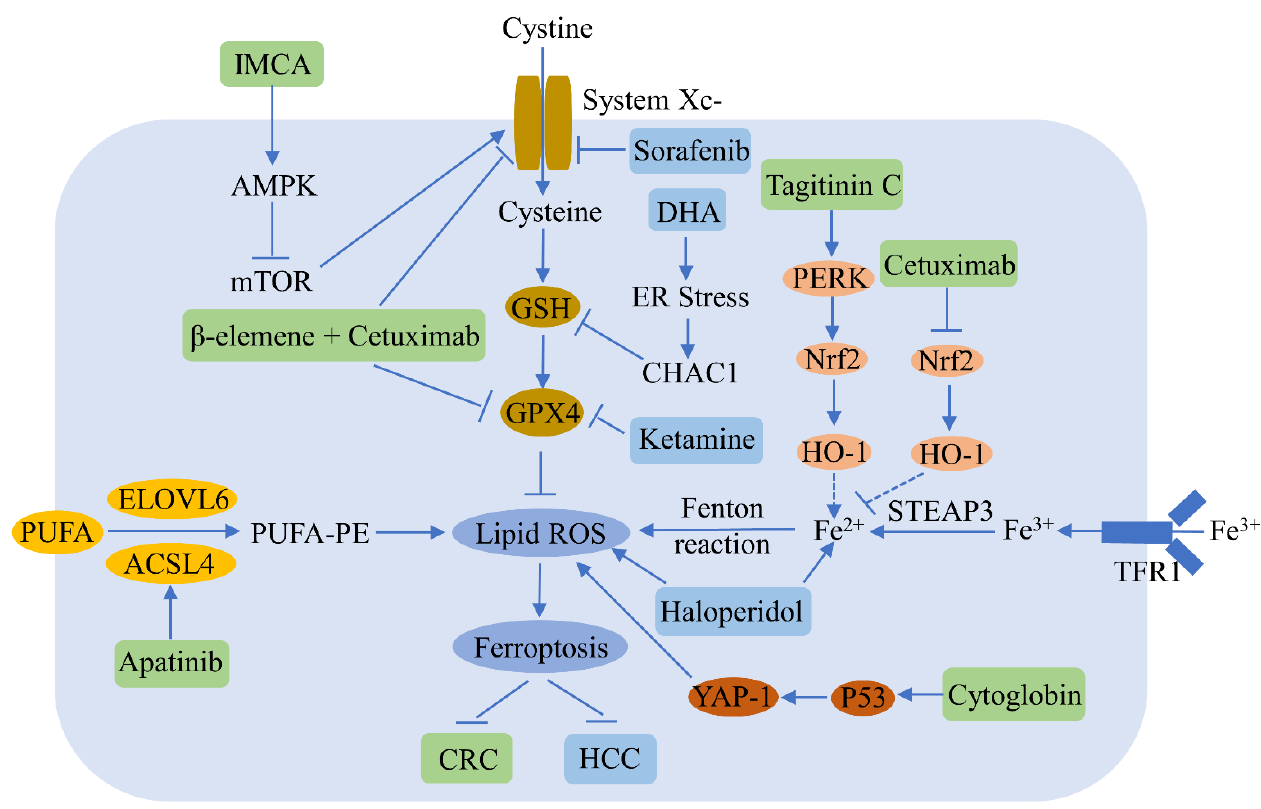
Figure 3. Ferroptosis regulators and pathways in hepatocellular carcinoma (HCC) and colorectal cancer (CRC). Ferroptosis can be a negative regulator of HCC and CRC. Various compounds can inhibit HCC and CRC growth by inducing ferroptosis. The blue and green patterns correspond to regulators for HCC and CRC, respectively. Sorafenib induces HCC ferroptosis by inhibiting SLC7A11. Dihydroartemisinin (DHA) triggers HCC ferroptosis by activating unfolded protein response and upregulating CHAC1. Ketamine increases HCC ferroptosis by inhibiting GPX4. Haloperidol promotes ferroptosis via the increase of Fe 2+ levels and lipid peroxidation in HCC. IMCA induces CRC ferroptosis by inhibiting SLC7A11. β -elemene and cetuximab combined treatment results in CRC ferroptosis by downregulating GPX4 and SLC7A11. Apatinib enhances CRC ferroptosis by up-regulating ELOVL6/ACSL4 signaling. Tagitinine C induces CRC ferroptosis via the up-regulation of the PERK-Nrf2-HO-1 signaling pathway. Cetuximab increases CRC ferroptosis by downregulating the Nrf2/HO-1 pathway. Cytoglobin increases CRC ferroptosis through the upregulation of p53 and YAP1.